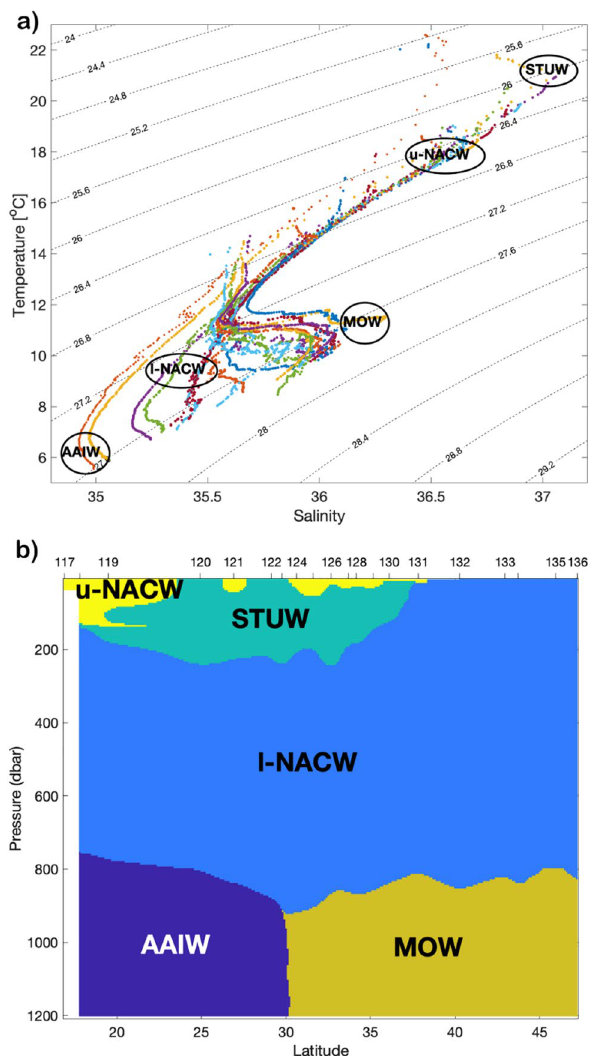
Figure 2. ( a ) Temperature-salinity diagram for all stations, each with different color, and schematic locations of water types: upper North Atlantic Central Water (u-NACW), lower North Atlantic Central Water (l-NACW), Subtropical underwater (STUW), Antarctic Intermediate Water (AAIW), and Mediterranean Overflow Water (MOW). ( b ) Overview of the different water types along the cruise track. The CTD stations (from 117 to 136) are indicated on the upper side of the plot. This figure was created using MATLAB, version R2018a from MathWorks (https:// www. mathw orks.